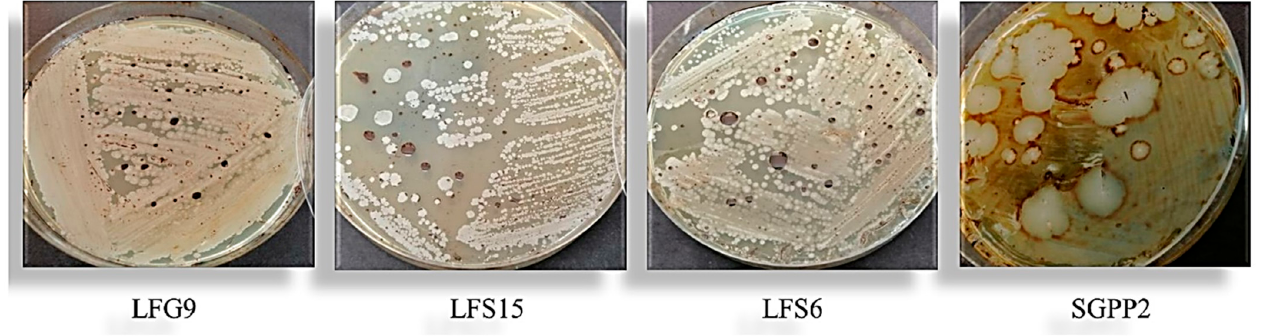
Figure 2. Oil-coated agar test of isolates Shinella zoogloeoides LFG9, Bacillus swezeyi LFS15, Bacillus safensis LFS6, and Pseudomonas guguanensis SGPP2 with crude oil as hydrocarbon substrate.